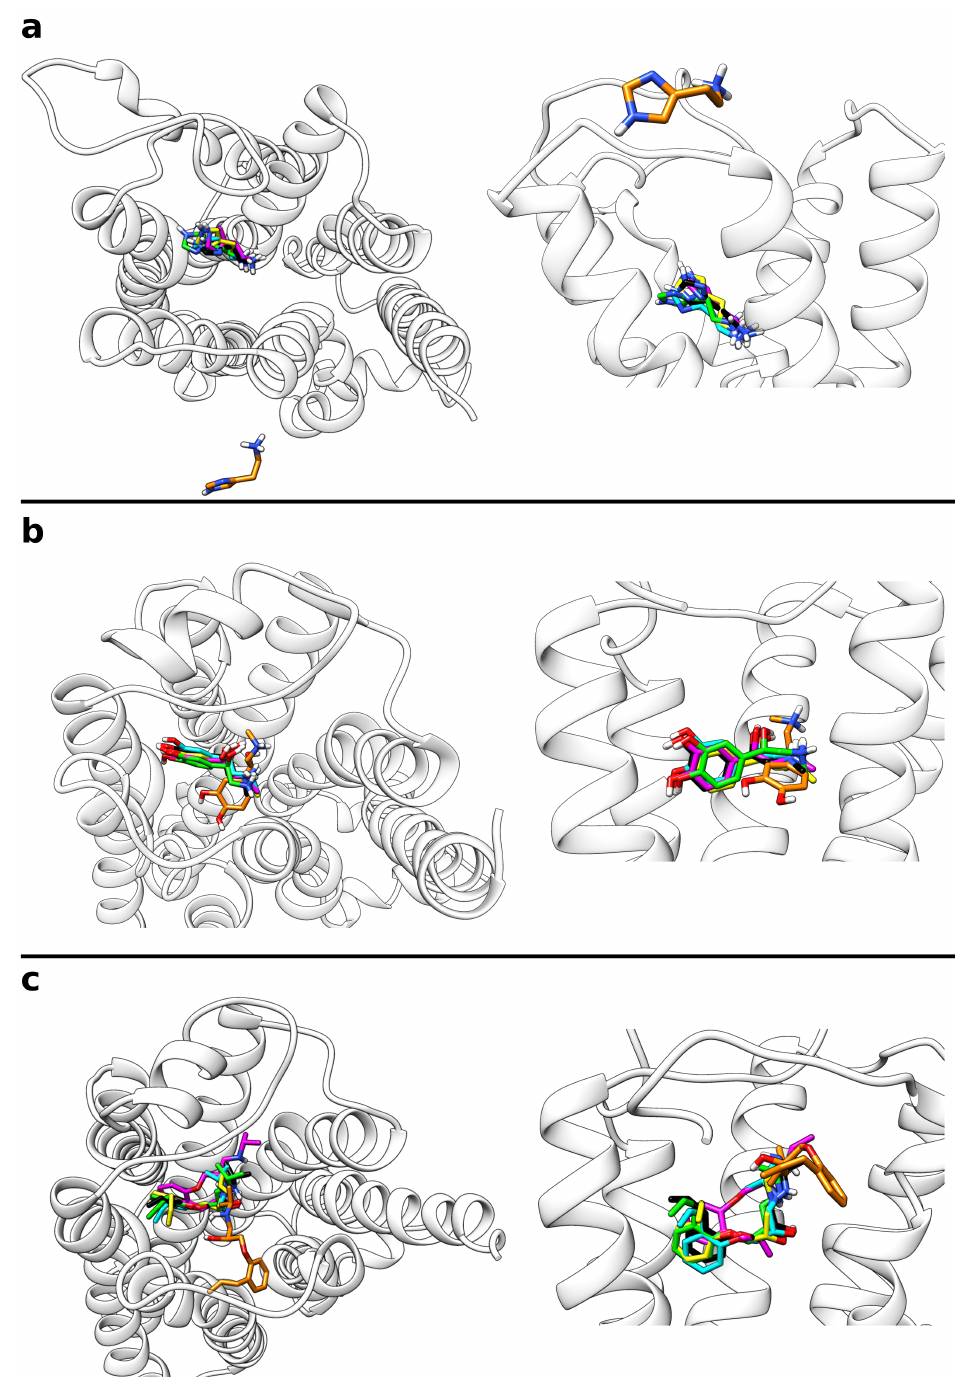
Figure 5. Overlay of all five final cluster structures from the unbiased MD simulations with the reference binding mode (left: top-view, right: zoomed-in lateral view). The ligands are shown as sticks with the carbon atoms of the reference ligand colored in black and those of the cluster structures colored in yellow (most populated), green, cyan, magenta and orange (least populated) according to the color scheme described in Figure 3. ( a ) Histamine in complex with the H 1 receptor, ( b ) adrenaline, and ( c ) alprenolol both in complex with the β 2